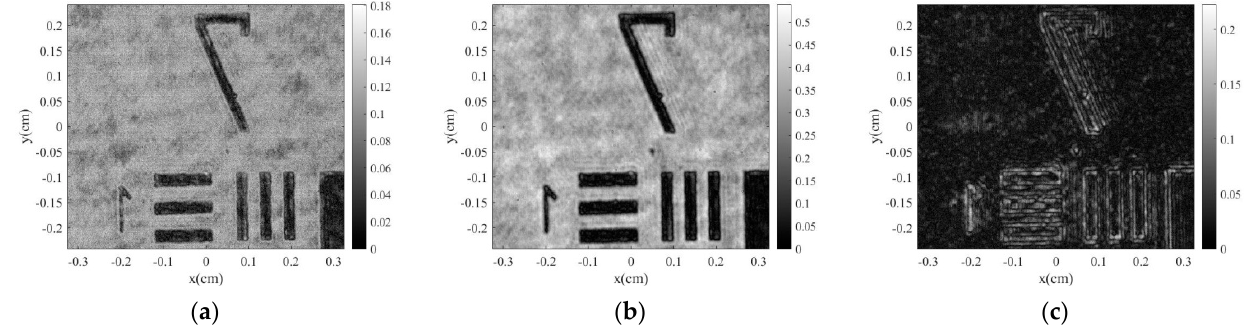
Figure 4. Reconstructed images of IDFDHM ( a , b ); control set under reflection-type configuration ( c ).